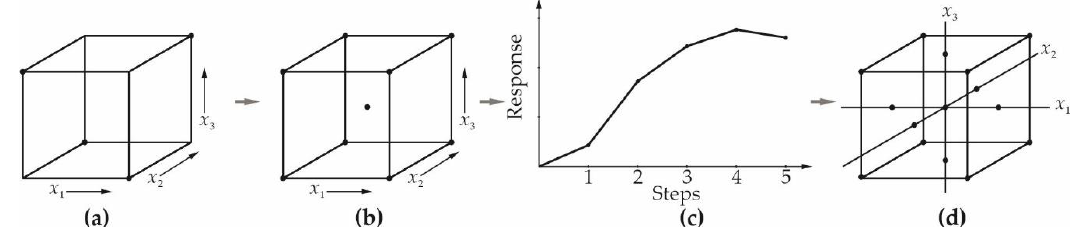
Figure 5. Scheme of response surface methodology (RSM) possible steps: ( a ) Fractional factorial; ( b ) full factorial with added centre points; ( c ) method of steepest ascent; ( d ) central composite design (CCD); adapted from Reference [17].